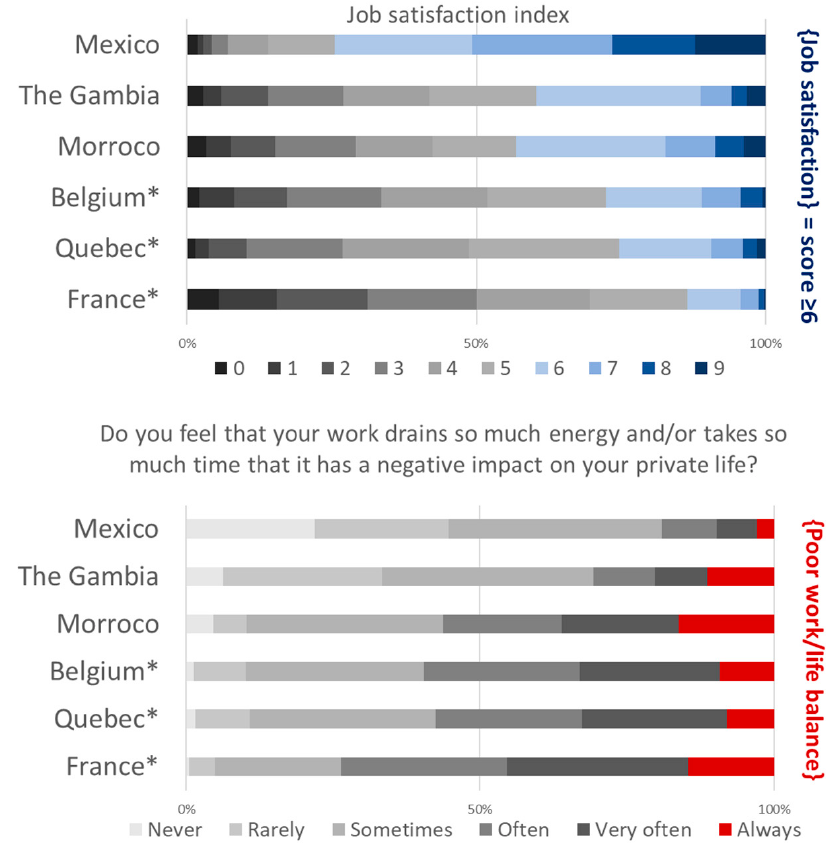
Figure 1. Two indicators of teachers’ wellbeing at work: job satisfaction, work/life balance, 2021 International Barometer of Education Personnel’s Health and Wellbeing (I-BEST). (* Weighted statistics taking into account gender and teaching level + age group in France and Belgium).